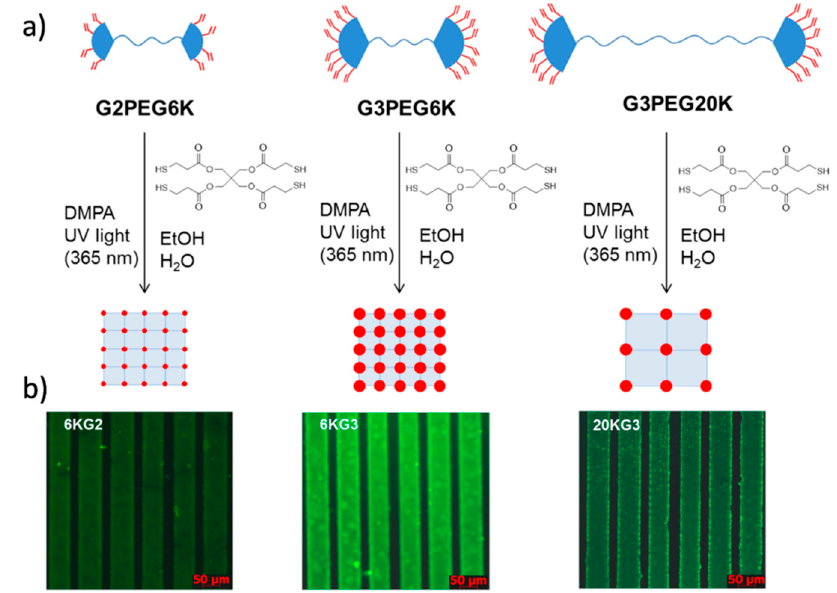
Figure 20. ( a ) Hydrogel formation using dendron polymer conjugates having different PEG lengths and dendron generations; ( b ) fluorescent microscope images of the obtained micropatterned hydrogels after post-modification functionalization with BODIPY thiol (DMPA: 2,2-Dimethoxy-2-phenylacetophenone). From [48], Copyright © 2015 by John Wiley & Sons, Inc. Adapted by permission of John Wiley & Sons, Inc.